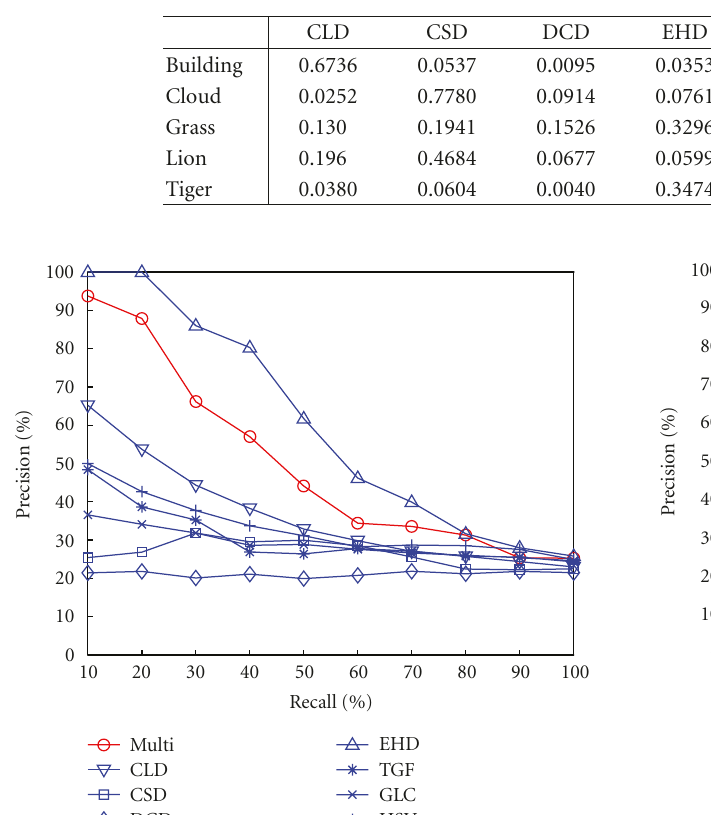
Figure 8: Precision-recall curves for concept building using the multifeature combination metric and using single descriptors.